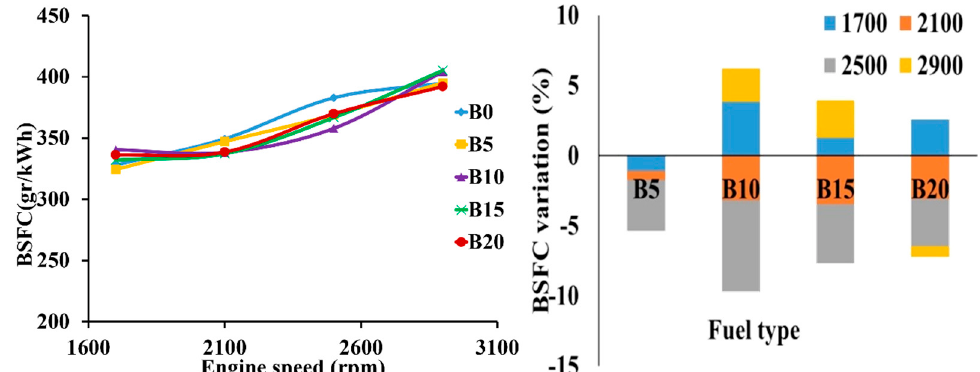
Figure 7. Variation of BSFC (gr/kWh) for different engine speeds and diesel biodiesel blends at full load.